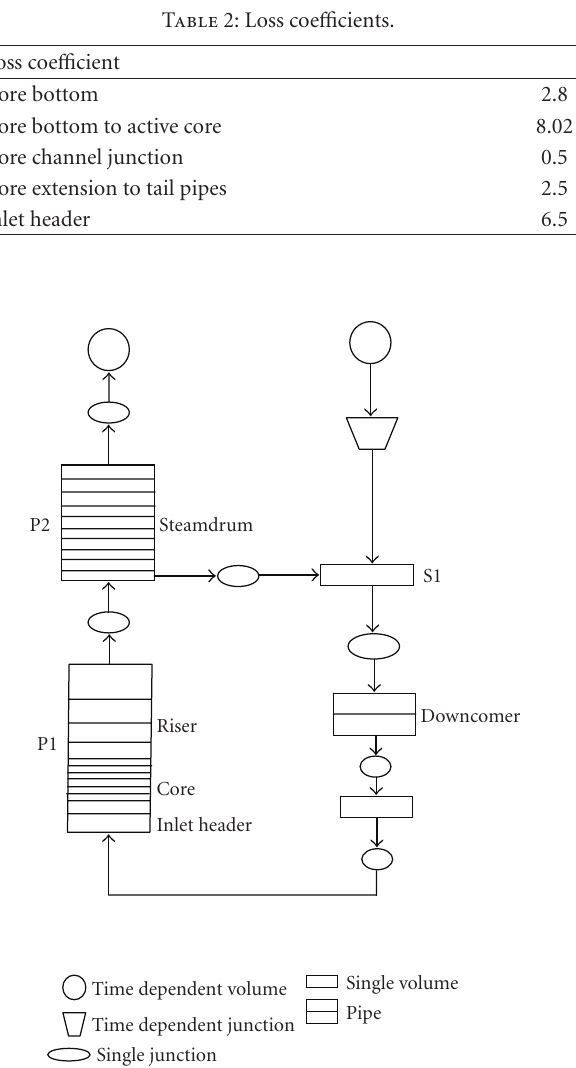
Figure 2: Nodalization diagram of